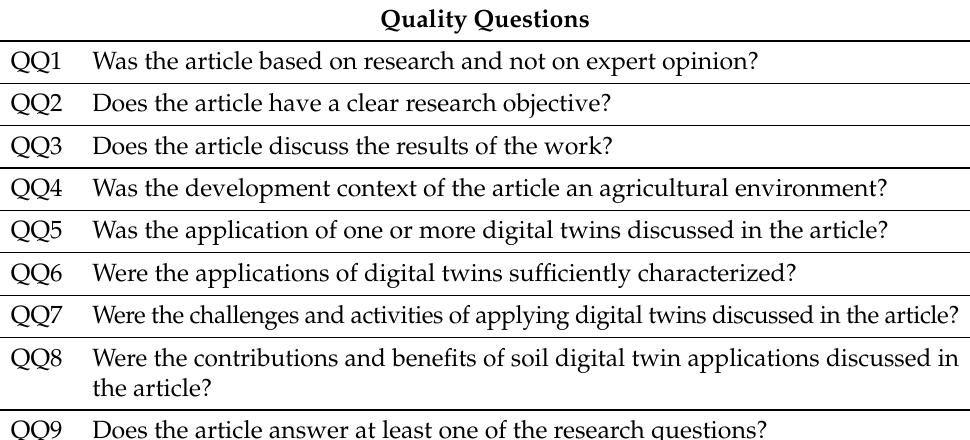
Table 6. Quality Questions.